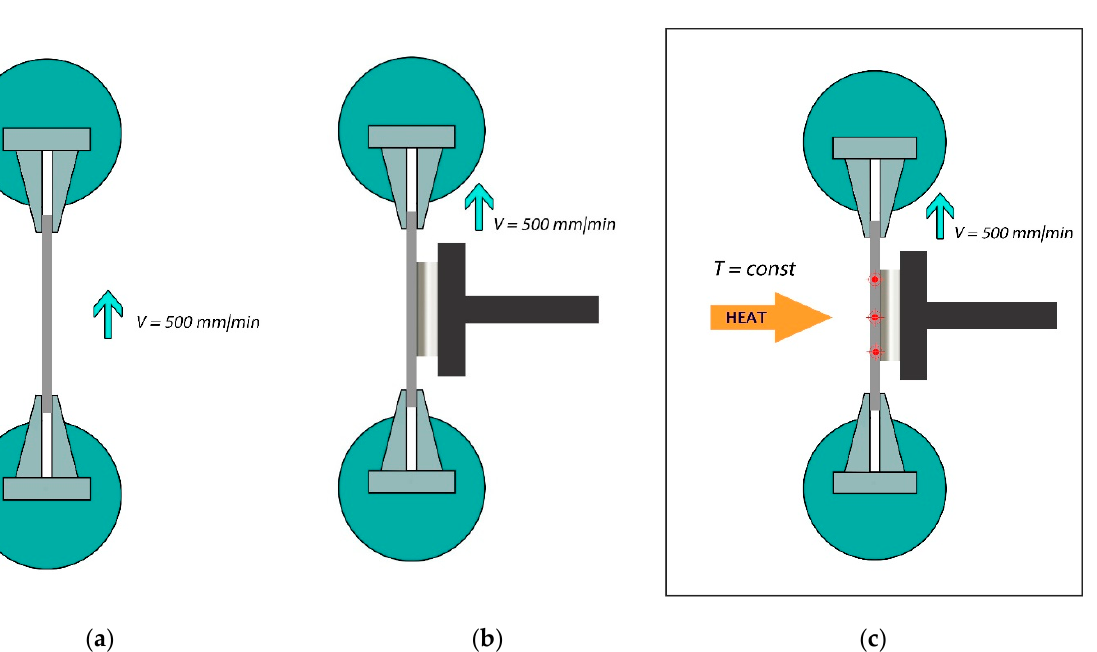
Figure 4. Experimental scheme for evaluating dynamic and mechanical properties of the MAE: ( a ) study without external influence; ( b ) study under the influence of an external magnetic field; ( c ) study under the influence of a combination of external magnetic and temperature fields.